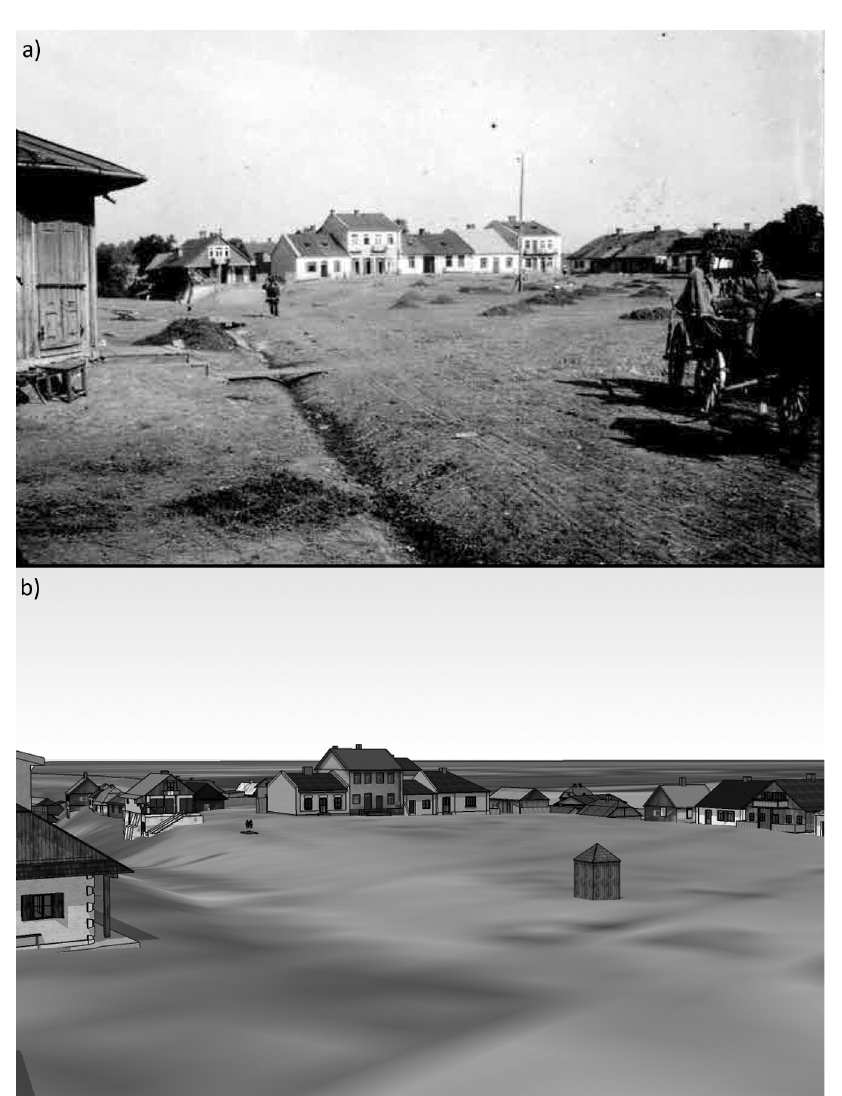
Fig. 6. Bychawa, the western face of the market square (poorly documented): a) the photo from 1915–1918 (found in Österreichisches Staatsarchiv in November 2017); b) the virtual mock-up Wirtualna Bychawa 1938 (finished in April 2017). The reconstruction achieved 83% (5 of 6